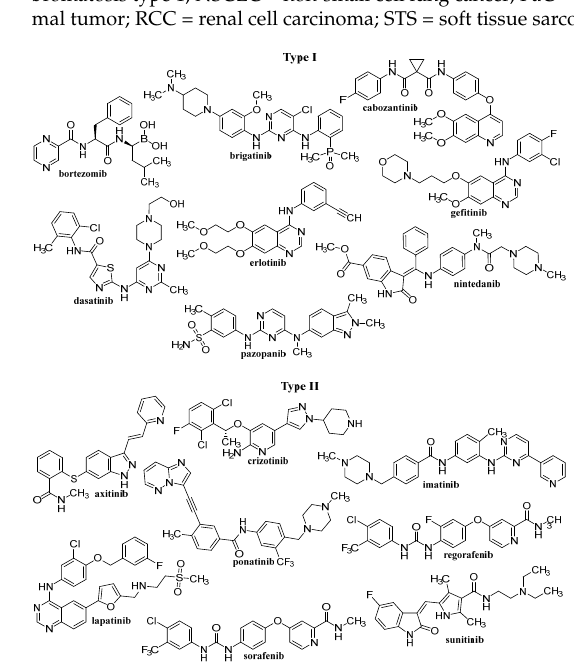
Figure 5. The structures of discussed TKIs of types III and V according to their mechanisms of action.